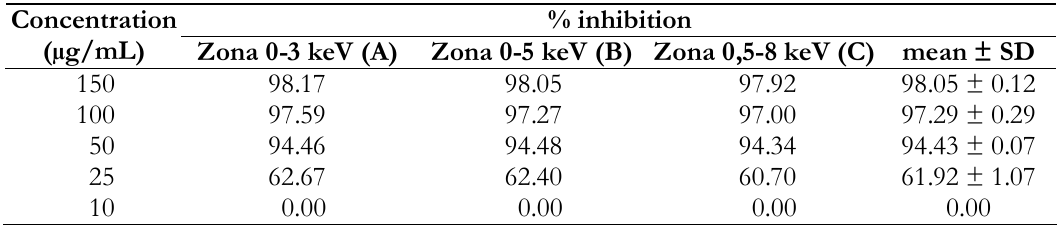
Table II. Inhibition of the growth (%) of chloroquine-sensitive P. falciparum (D-10) due to administration of 8-hydroxyisocapnolactone-2  3  -diol on the three measurement